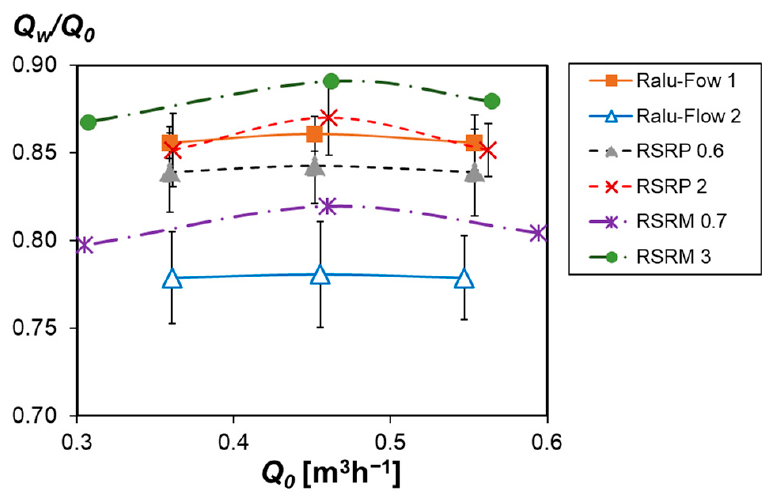
Figure 7. Average relative wall flow rate of plastic Raschig Super–Ring and Ralu–Flow in peripheral initial distribution, compared with data on metal Raschig Super–Ring [41].